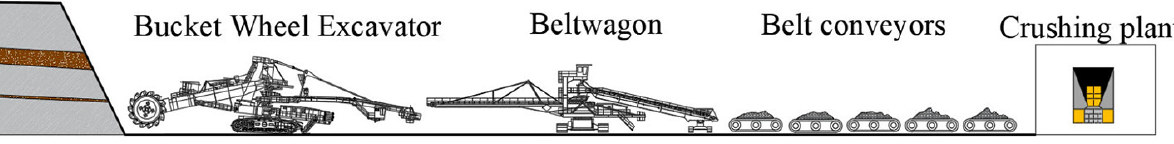
Figure 1. Overview of the ECC system [12].